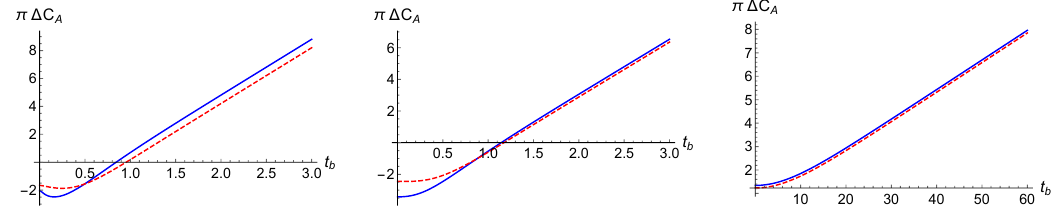
Figure 4 . π ∆ C A ( t b ) with M = 2 , ‘ = G N = α = L ct = 1 and (left) J = 0 . 1 , (center) J = 1 , (right) J = 1 . 999 . CA with the counterterm is depicted in blue solid, in red dashed without. that the two cutoffs, r in BTZ and r AdS in AdS, differ by a linear term in the FG cutoff. max max Such a linear correction does not yield any finite term to CA in the limit where the cutoff is removed. Thus for our purpose we can simply identify r AdS = r max max